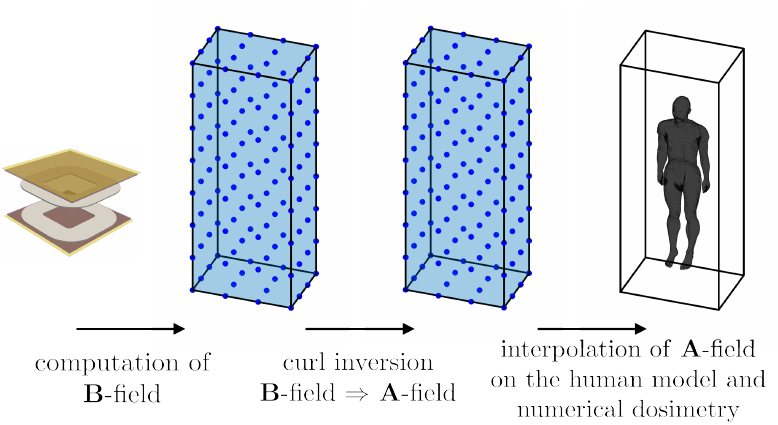
Figure 5. The human model is bounded in a hexahedral grid. Knowing the B -field at the blue points, it is possible to define a compatible A -field that, after interpolation, is used as the source term in Equation